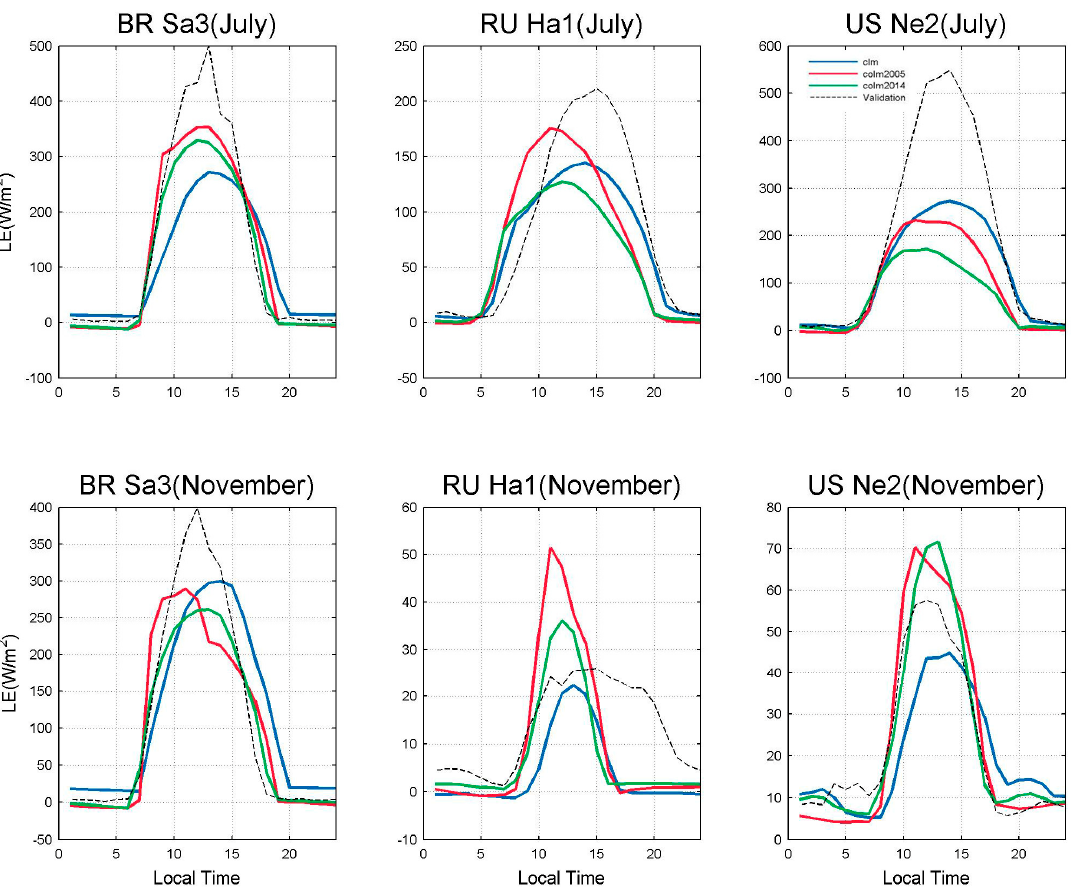
Figure 11. Monthly mean diurnal cycles of latent heat flux at three sites (BR-Sa3, RU-Ha1, and US-Ne2) during two months (July and November 2003) (Units: W m − 2 ).